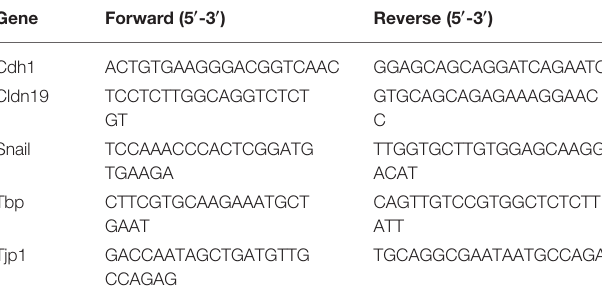
TABLE 1 | Sequences of used